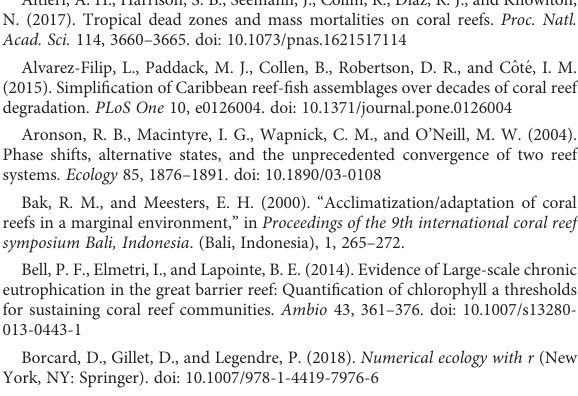
SUPPLEMENTARY DATA SHEET 2 Supplementary methods, fi gures, and